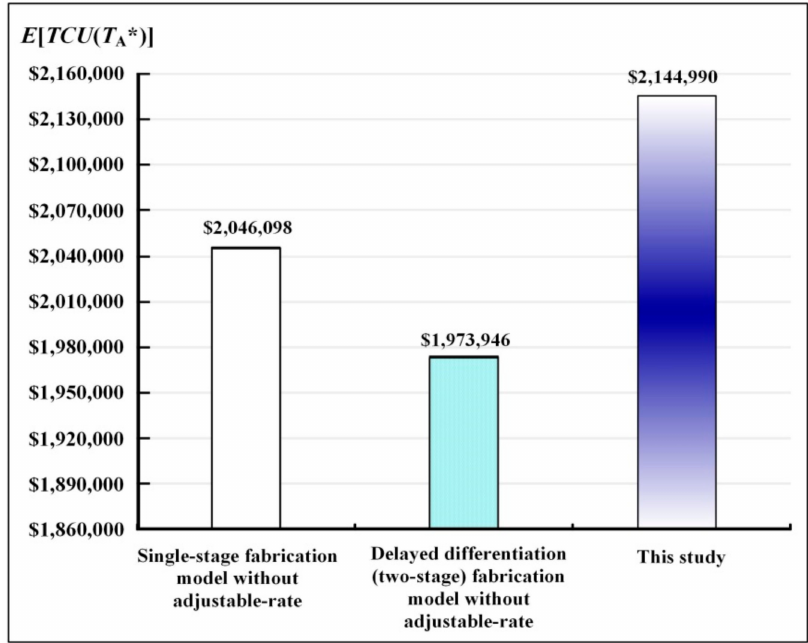
Figure 8. Comparing this study’s E [ TCU ( T A *)] with other closely related